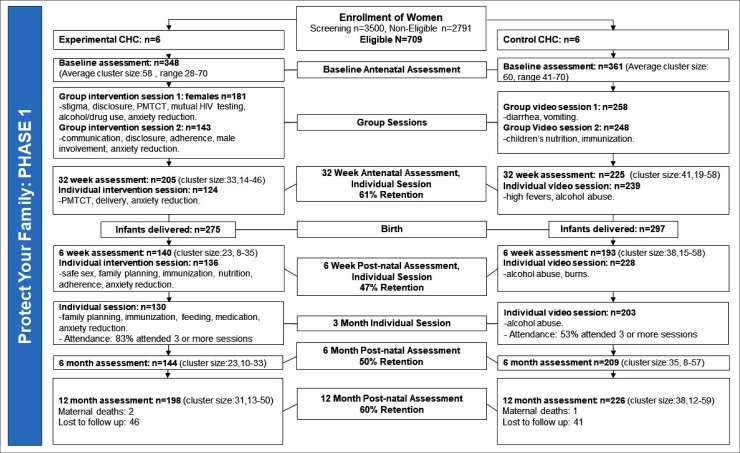
CONSORT diagram outlining enrolment procedures for Phase 1.